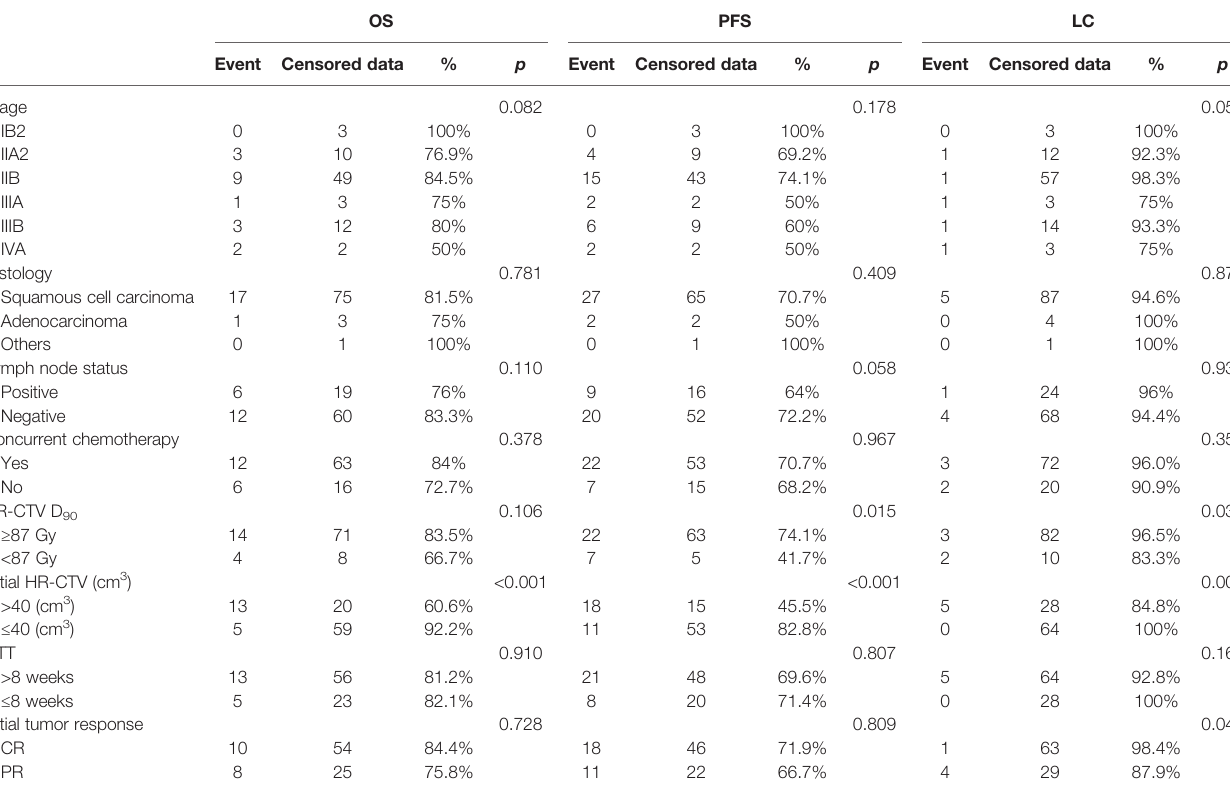
TABLE 3 | Univariable analyses (classi fi cation